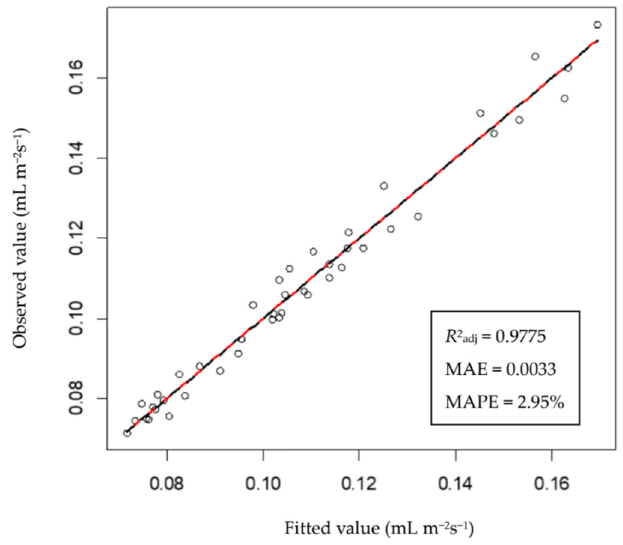
Figure 4. Relationship between the fitting and observed values of the testing dataset of the evapo- transpiration model. The red line is the fitted regression line between the observed and fitted values, and the black dashed line is a straight line with a slope of 1.